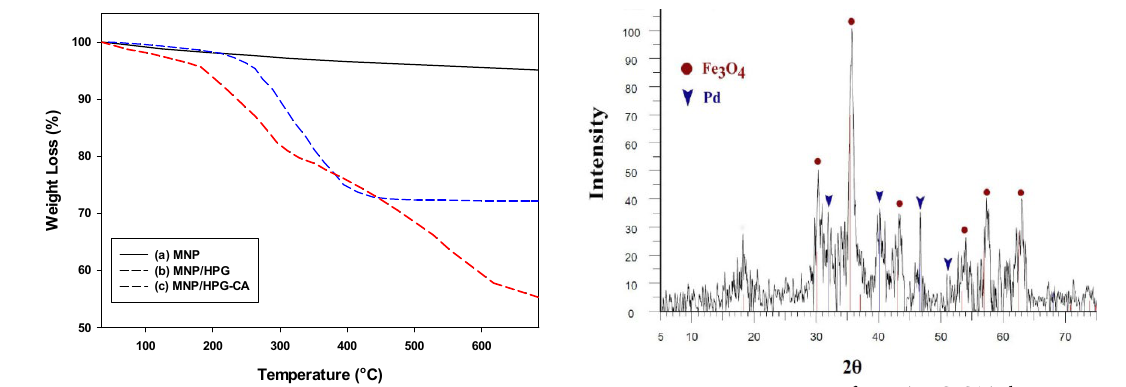
Fig. 2. XRD patterns of Figure 2 XRD patterns of MNP/HPG-CA/Pd Fig. 1. The TGA spectra of: a) MNP; b) MNP/HPG; c) MNP/ Figure 1 The TGA spectra of: a) MNP; b) MNP/HPG; c) MNP/HPG-CA HPG-CA